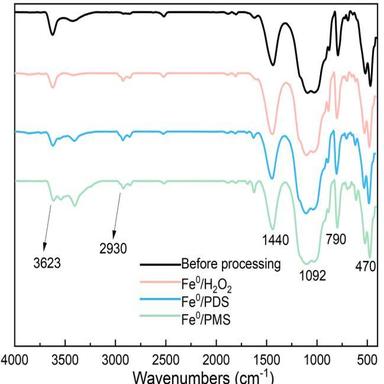
FTIR spectra of OBDC before and after treatment with the Fe0 /PMS, Fe0 /PDS, and Fe0 /H2O2 systems.